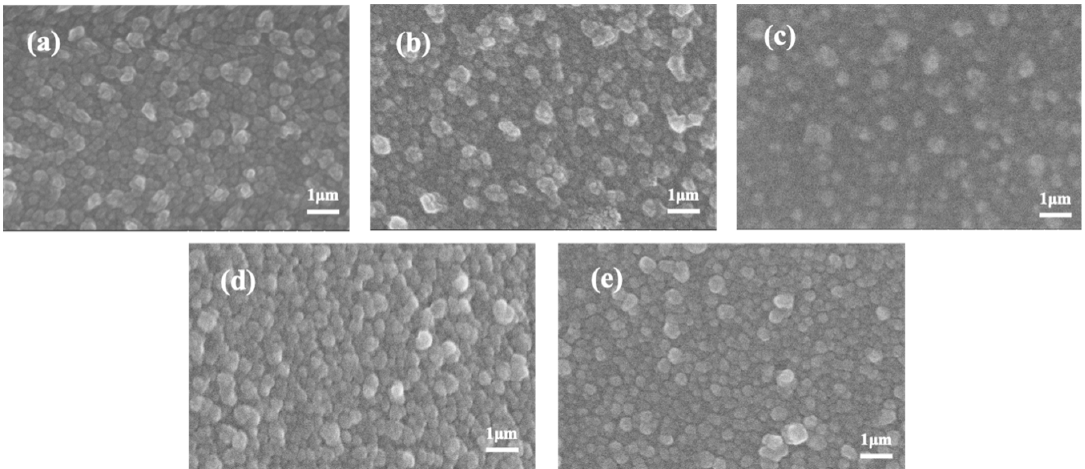
Figure 2. SEM characterization of thin-film composite NF membranes with different concentrations CaCl 2 added in the post-treatment: ( a ) NF-control, ( b ) NF-10, ( c ) NF-20, ( d ) NF-40, ( e ) NF-80.